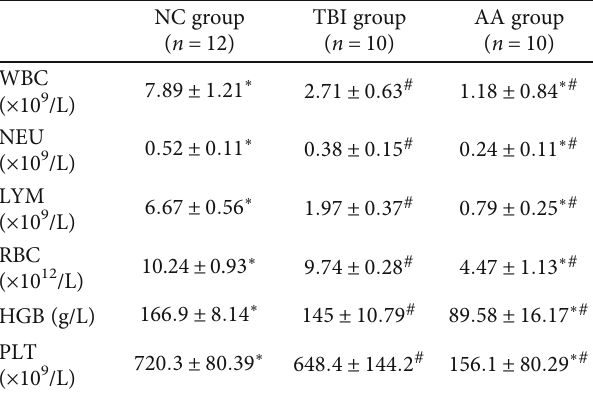
Table 1: Blood counts in the NC, TBI, and AA model